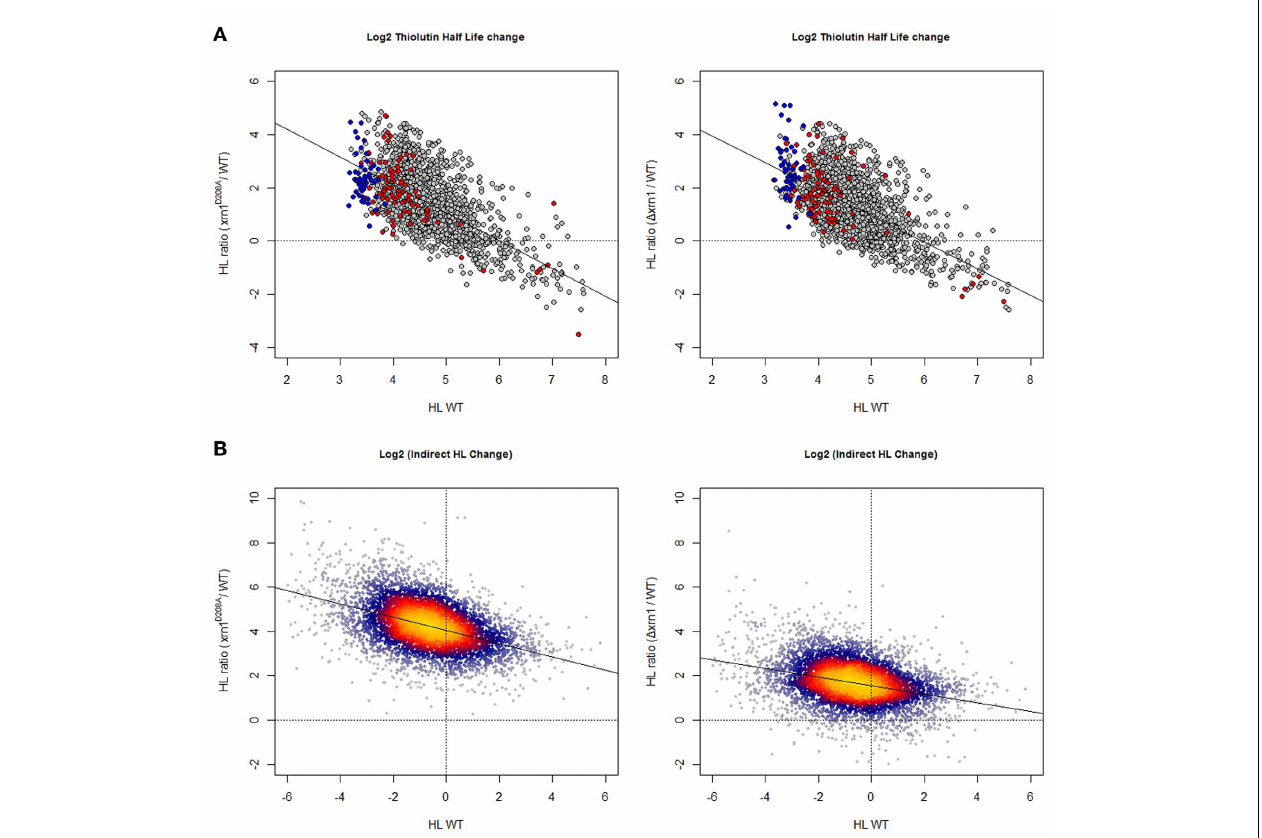
FIGURE 1 | Changes in mRNA HL due to disruption of Xrn1 inversely correlate with mRNA stability. (A) Plots of the ratios between mutant and wild-type HL against HL in the wild type (wt). The cloud shows 1915 data for the genes with confident HL measures in a shut-off with thiolutin in both wt and mutants (see Materials and methods for details). (B) The same kind of plots, but using 5400 data points from an indirect HL determination using the GRO protocol and